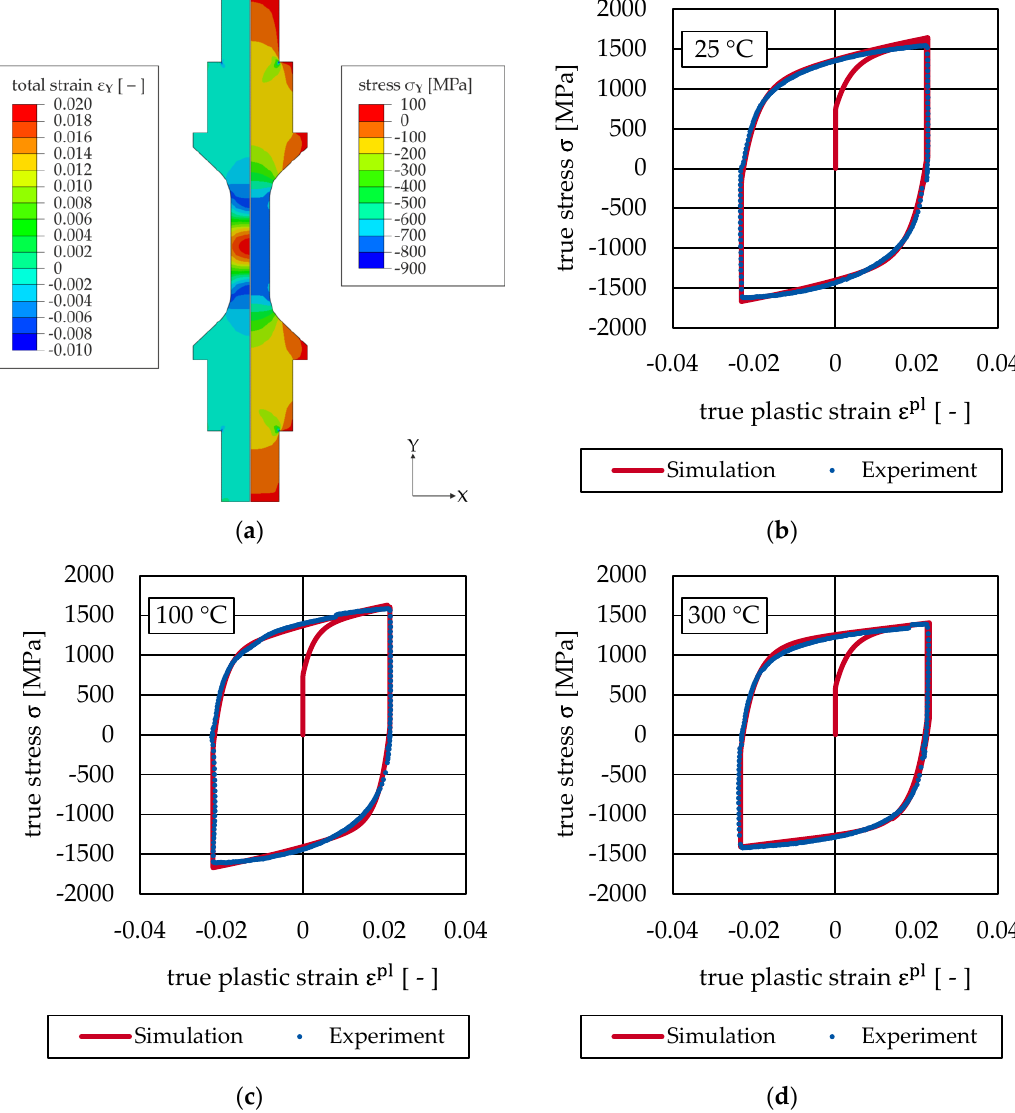
Figure 7. ( a ) Exemplary results for the simulation of strain-controlled cyclic tests after one complete cycle, ( b ) comparison of strain-controlled cyclic tests with the derived material model used in the simulation at a temperature of 25 °C, ( c ) 100 °C, and ( d ) 300 °C.